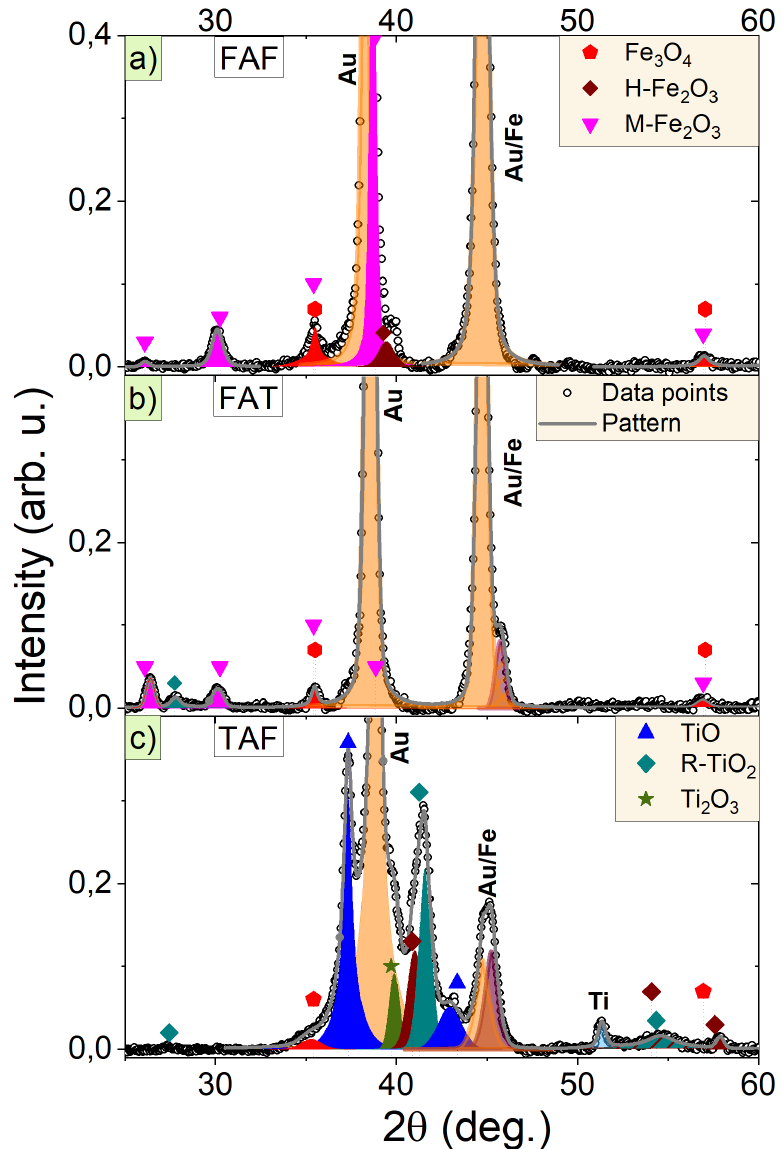
Figure 2. XRD patterns for ( a ) FAF, ( b ) FAT, ( c ) TAF metal/metal oxide/metal junctions. The titanium and iron oxides are marked with different tags corresponding to different metal